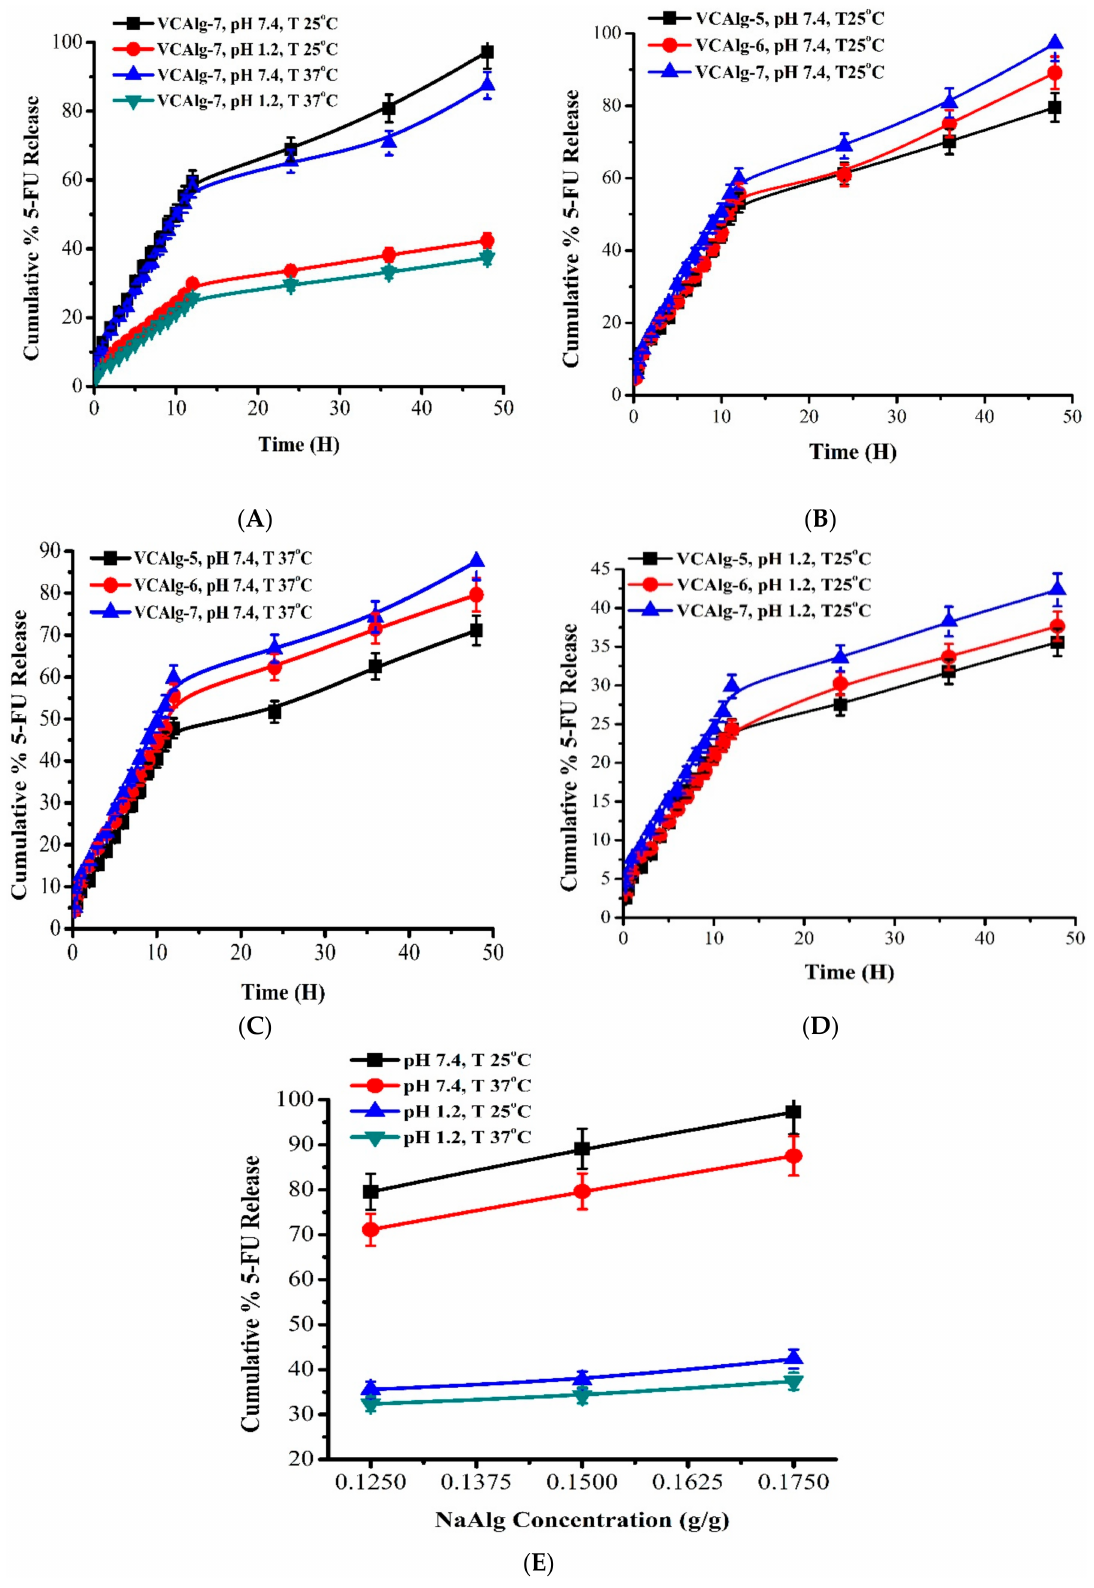
Figure 10. The response of thermoresponsive Poly (NVCL-g-NaAlg) depot gels to in vitro cumulative 5-FU release at variable pH and temperature programs. A significant difference was seen in drug release data at pH = 7.4 and 1.2. The data were analyzed with one-way ANOVA and found significant with p -value of <0.001 ( A ). Effect of increasing NaAlg concentrations in feed composition ratio